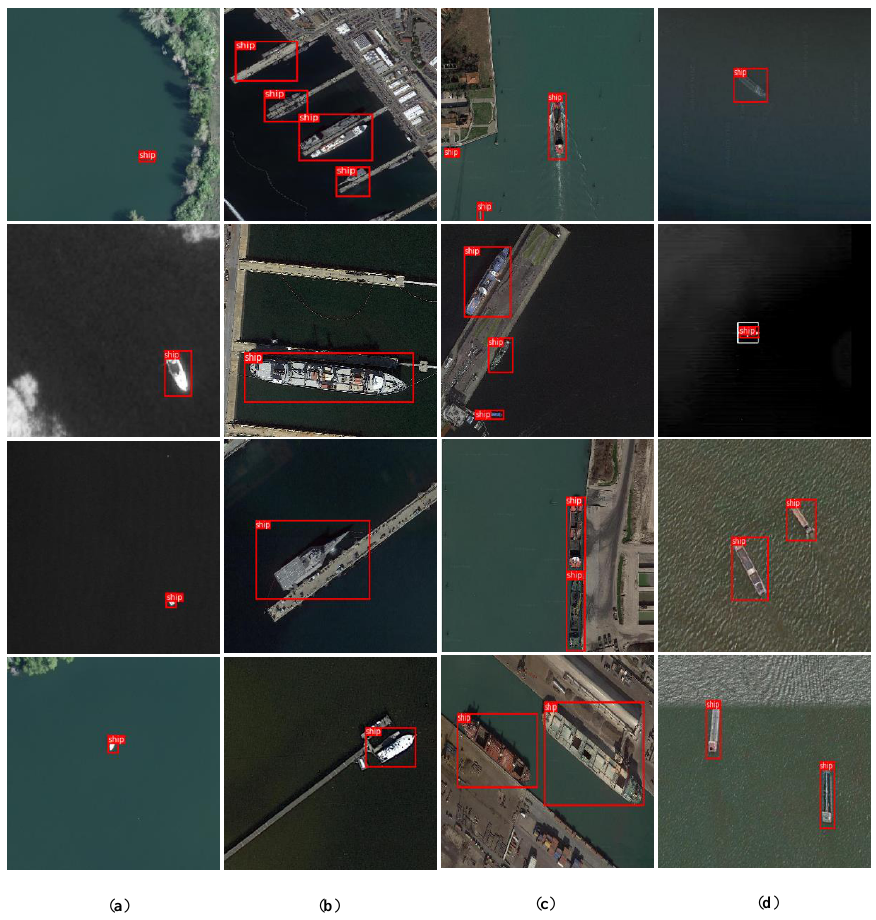
Figure 22. Ship detection results of CFF-SDN model on other datasets. ( a ) Ship detection results for vehicle detection in aerial imagery (VEDAI) dataset; ( b ) Ship detection results for dataset for object detection in aerial images (DOTA); ( c ) Ship detection results for high-resolution remote sensing object detection (HRRSD) dataset; ( d ) Ship detection results for our DSDR dataset.